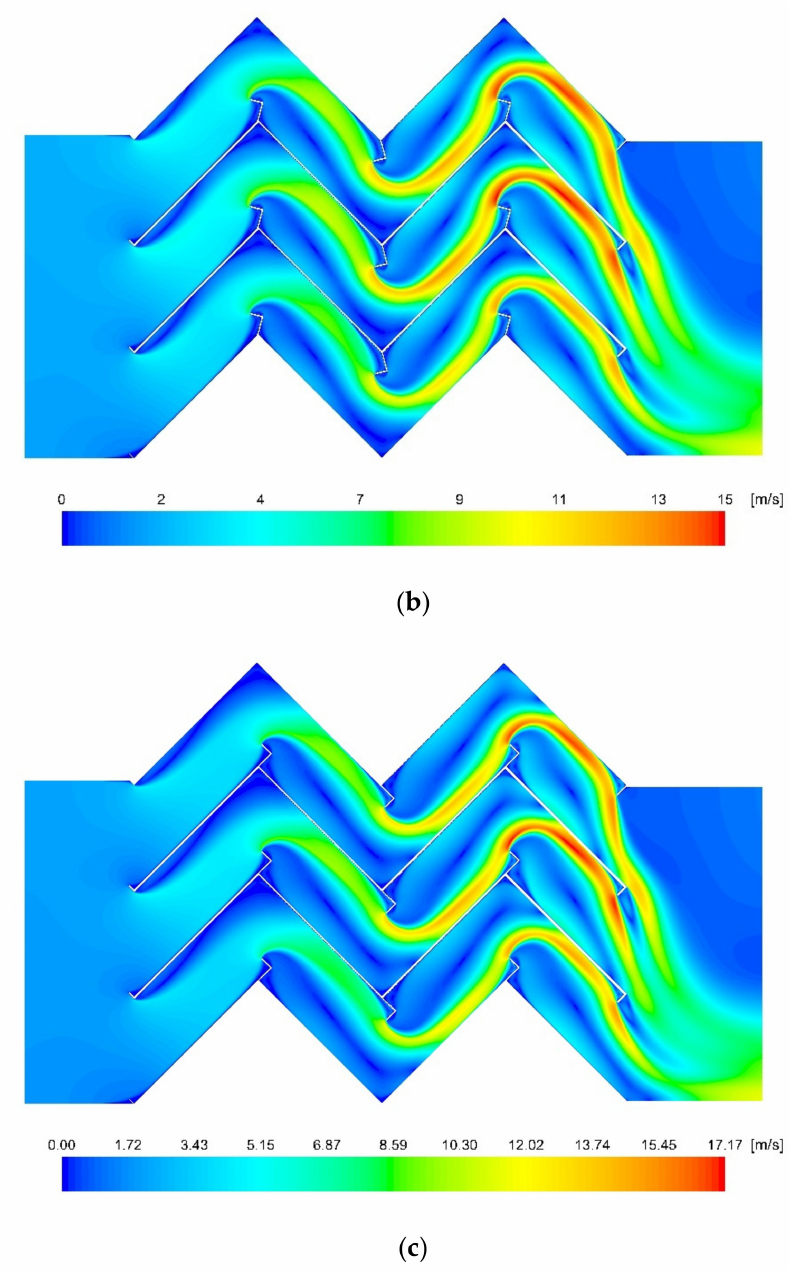
Figure 13. Velocity fields (m s − 1 ) of investigated geometry variants with different drainage channel angles: ( a ) B_10_30; ( b ) B_10_60; ( c ) B_10_90; for inlet velocity 2 m s − 1 , simulated using a transition SST